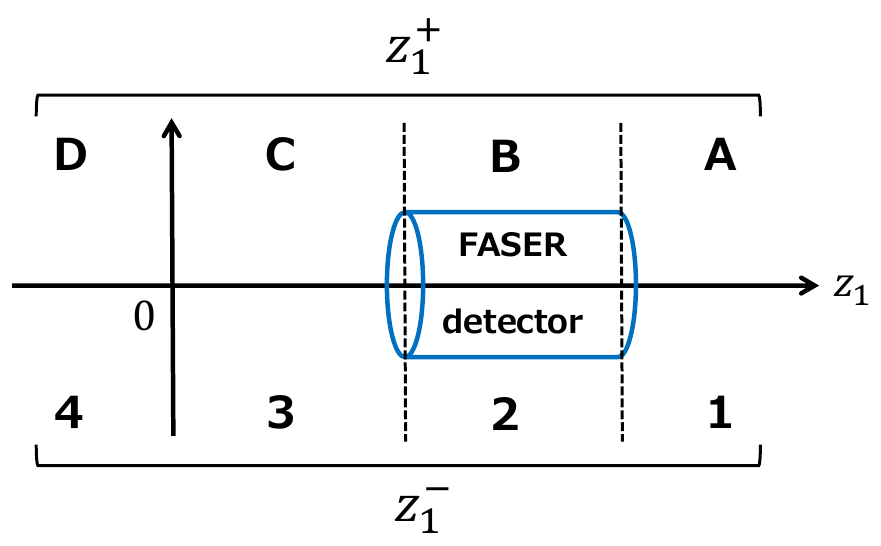
Figure 8 . A schematic view of the z 1 coordinate for the case of the gauge boson decay.